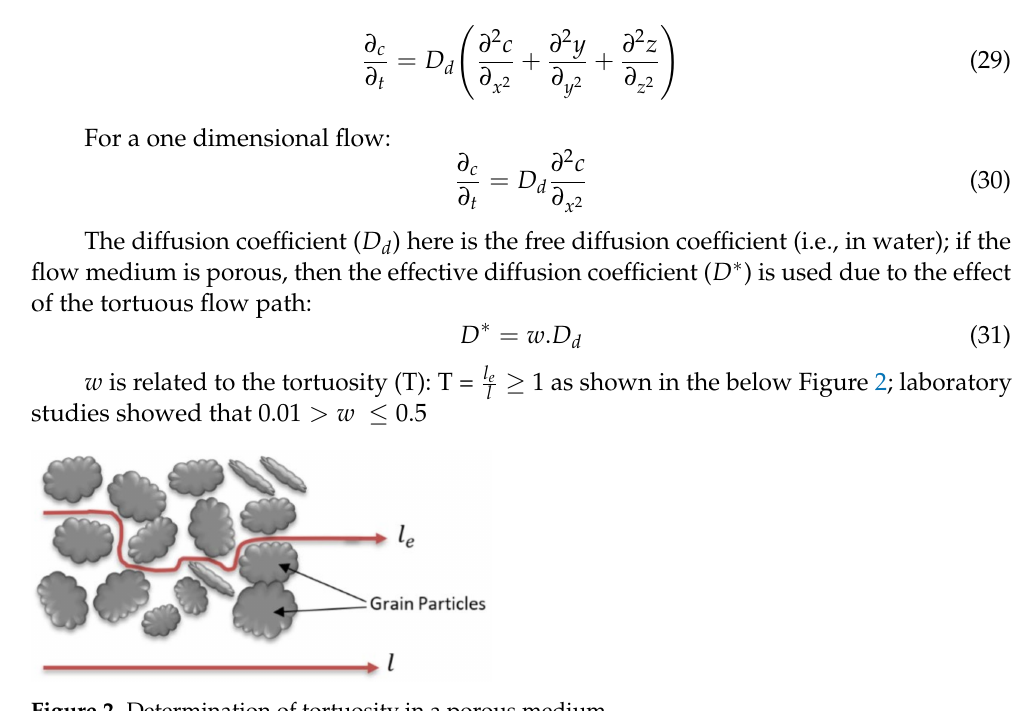
Figure 2. Determination of tortuosity in a porous medium.